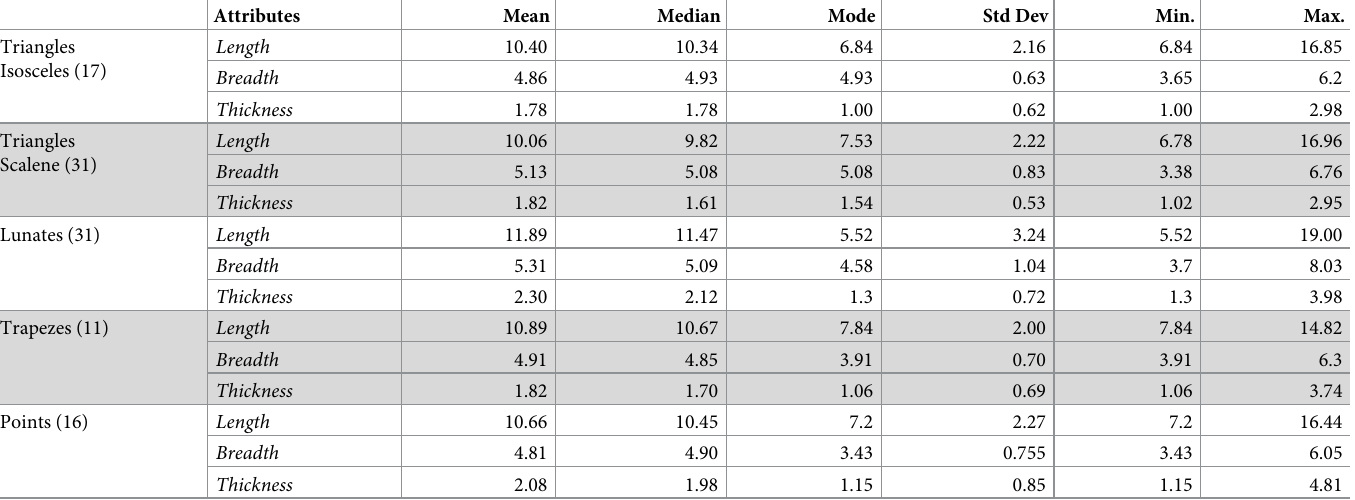
Table 2. Summarised metric data (in mm) of the geometric and non-geometric tools from Vaharvo Timbo.